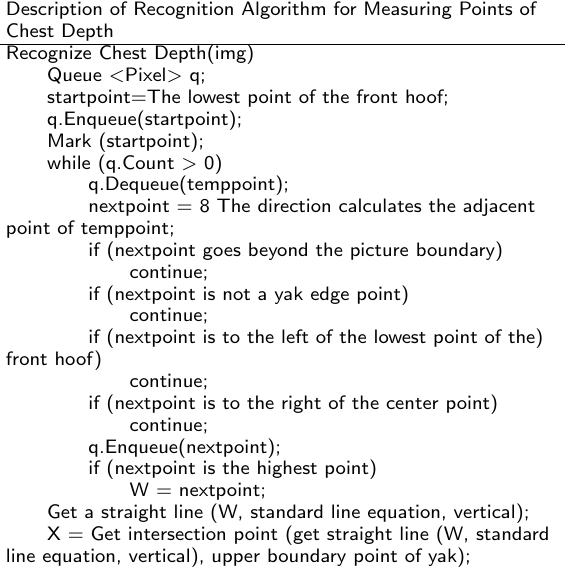
Algorithm 4 Recognition Algorithm of Measuring Points of Chest